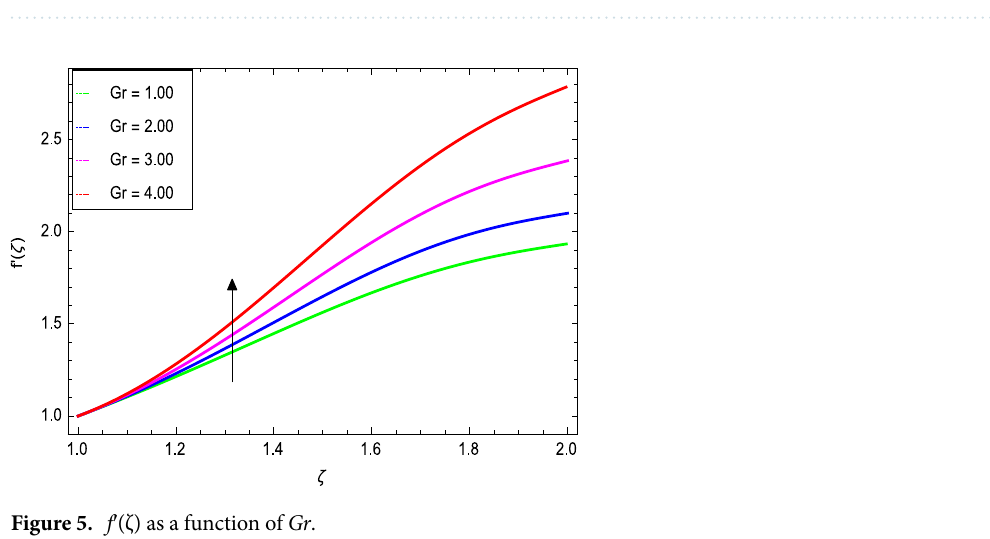
Figure 5. f ′ (ζ) as a function of Gr